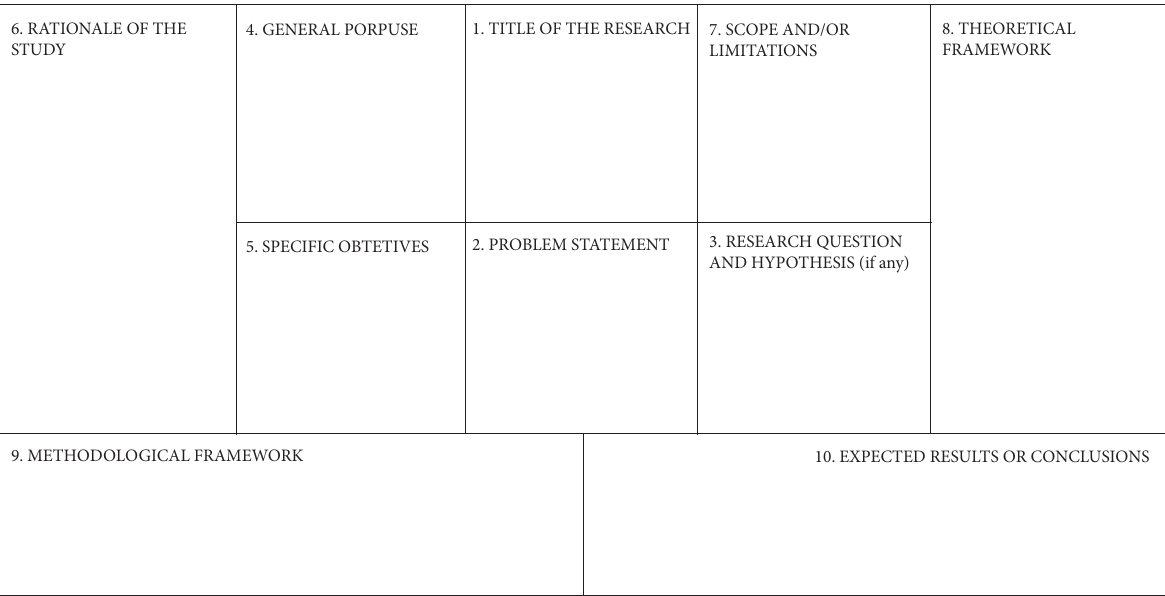
Figure 4: Canvas Model for Research Projects (CMRP). Elaborated by F´elix Socorro. November